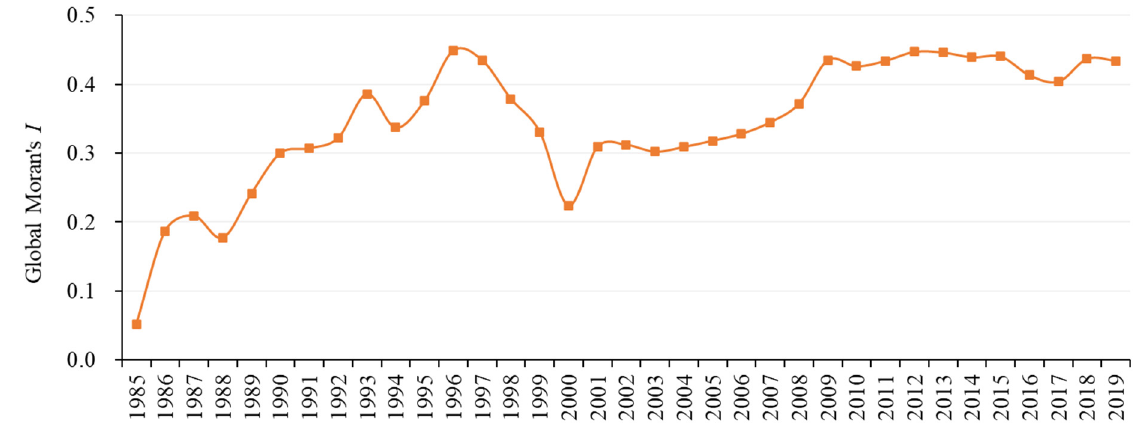
Figure 3. Changes in the global Moran’s I of NGF in China from 1985 to 2019.